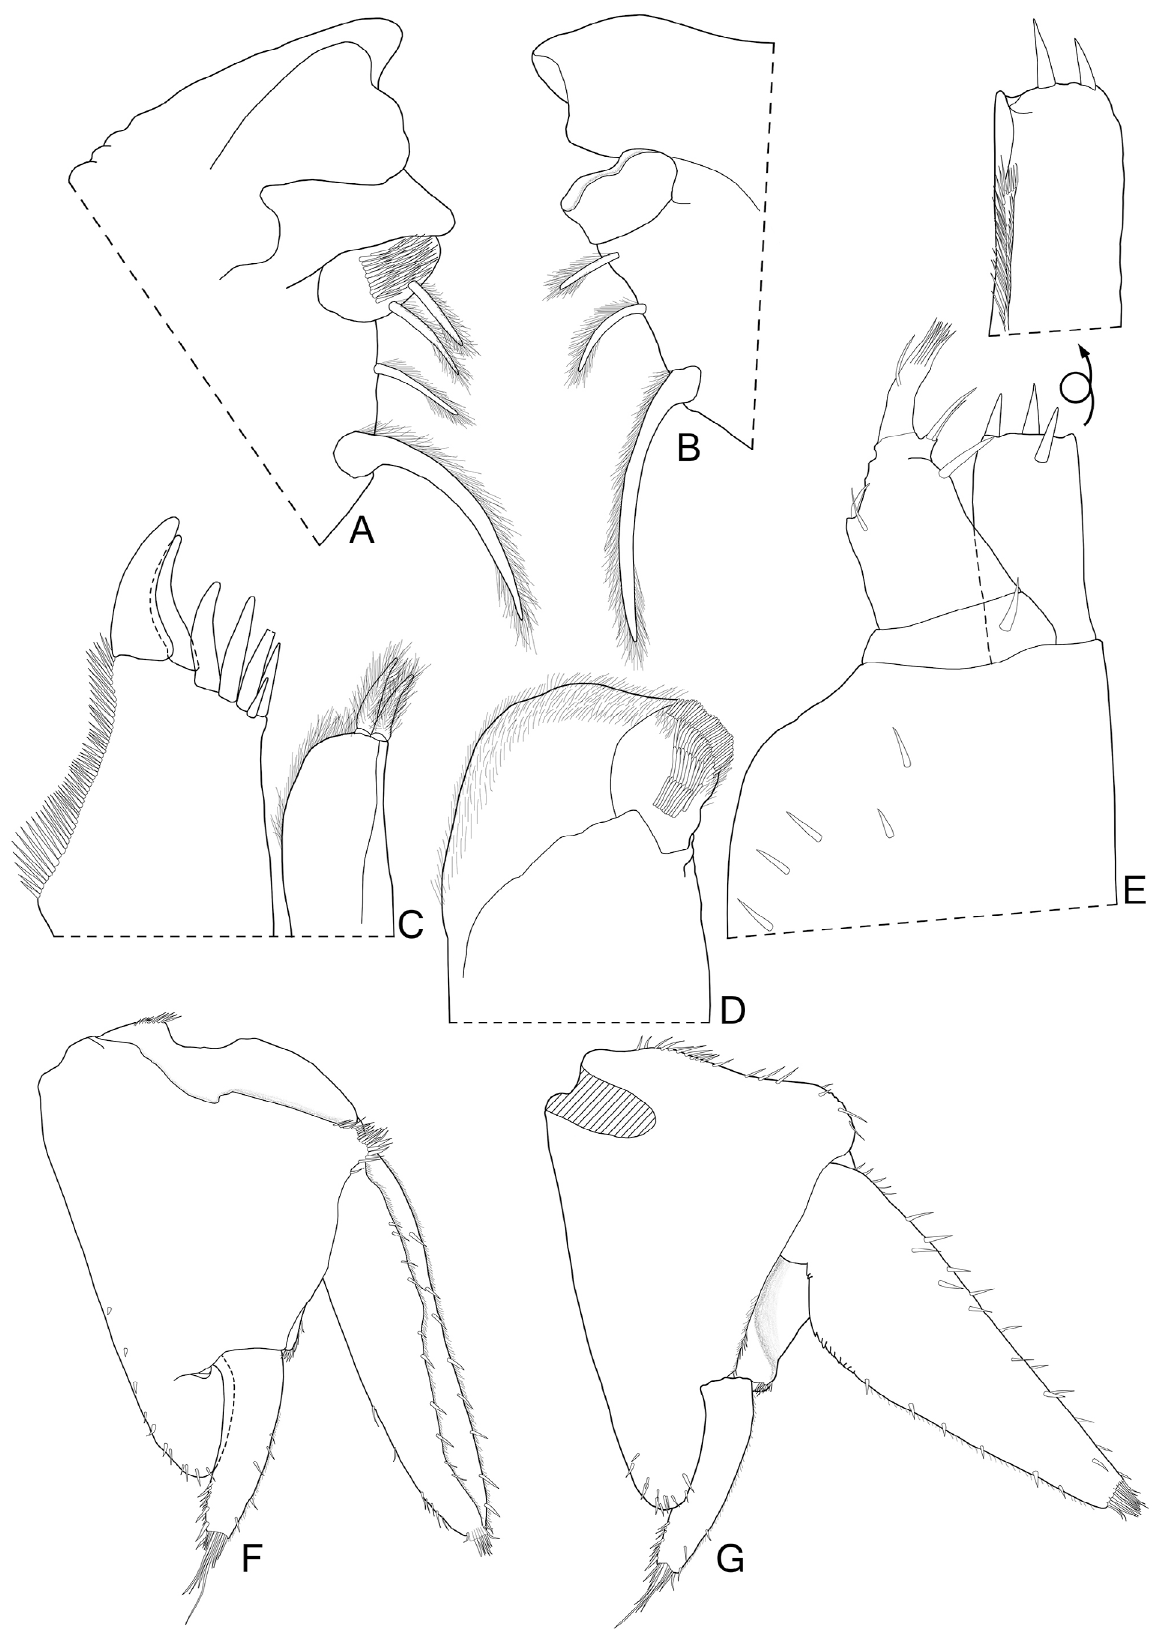
Figure 4. Caecopactes chullachaqui Campos-Filho, Sfenthourakis and Bichuette sp. nov, paratype. A , Left mandible; B , right mandible; C , maxillula; D , maxilla; E , maxilliped; F , uropod, ventral view; G , uropod, dorsal